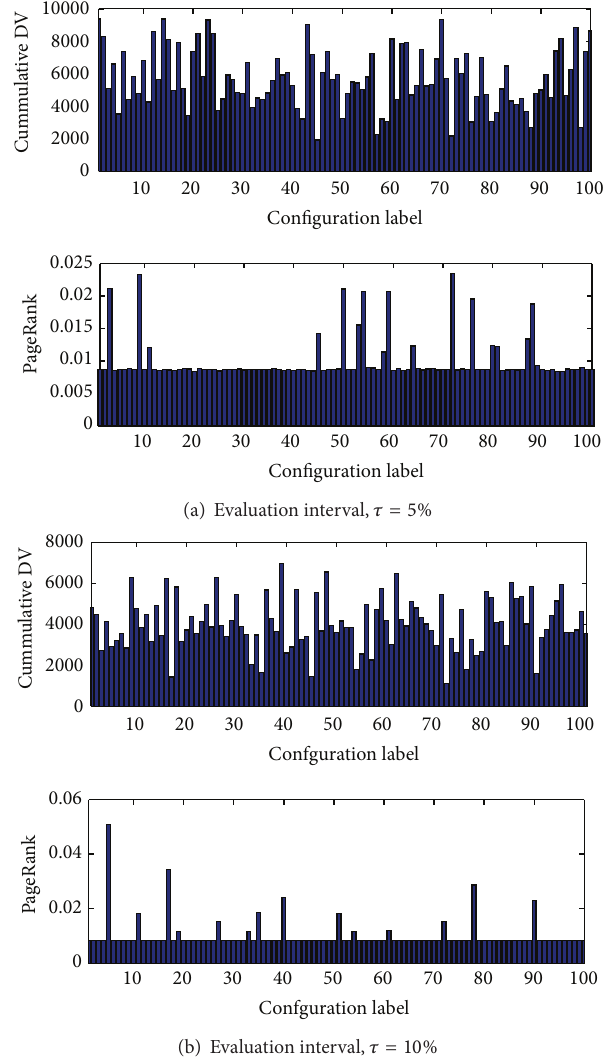
Figure 9: CDV and PR of various configurations (a) and